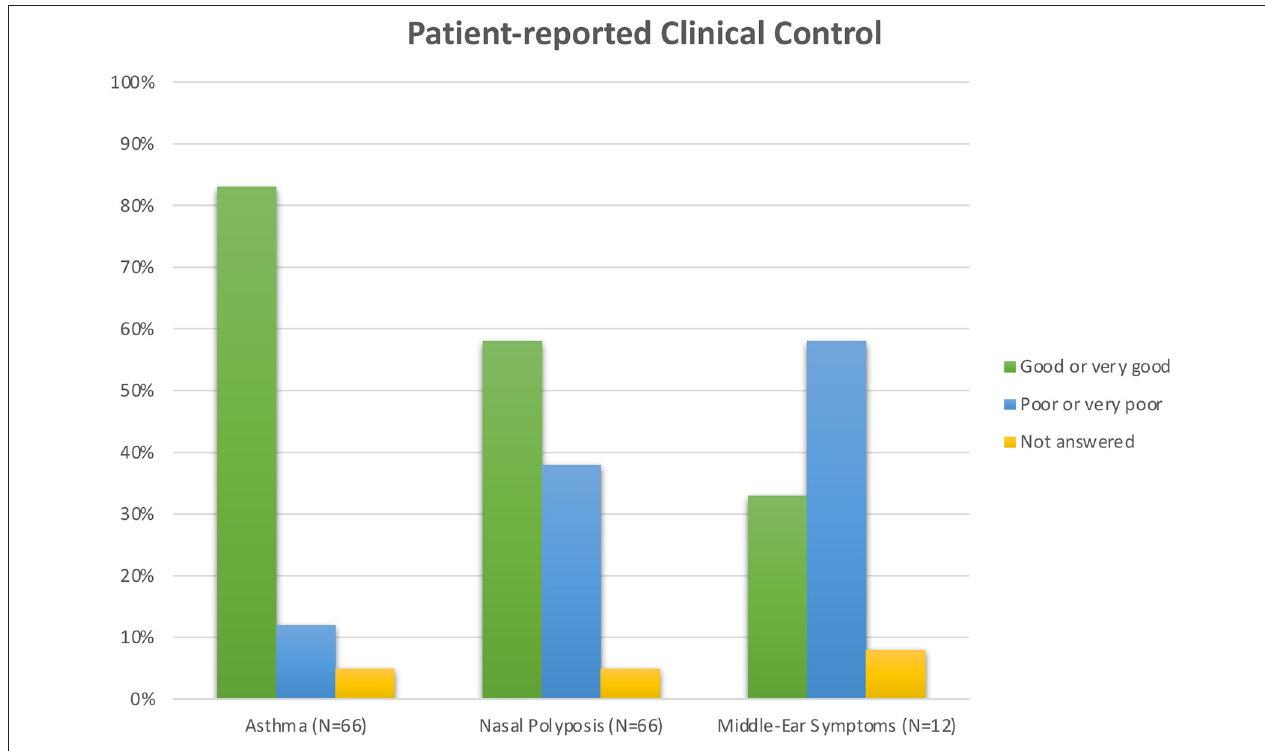
FIGURE 3 | Patient-assessed disease